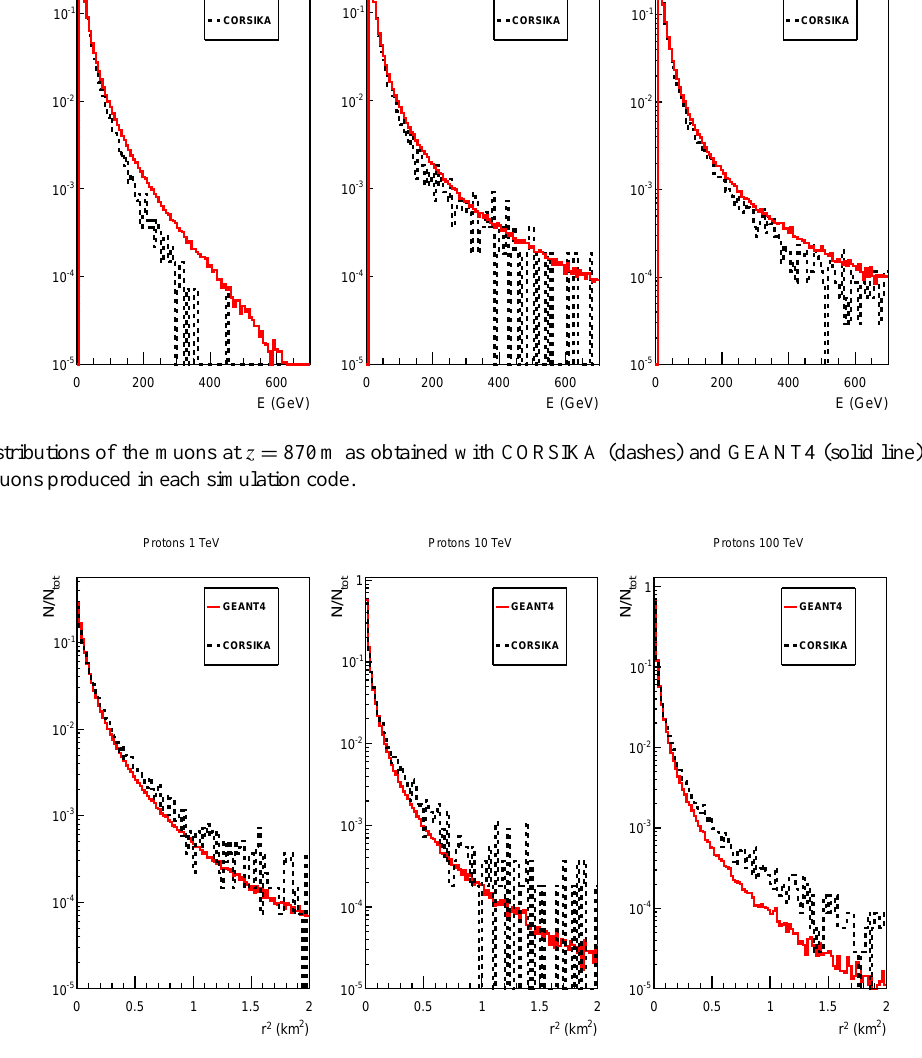
Fig. 3. Lateral distributions of the muons at z = 870m as obtained with CORSIKA (dashes) and GEANT4 (solid line), normalised to the total number of muons produced in each simulation code. r is the distance to the centre of gravity of the muons in each shower, computed in the detection